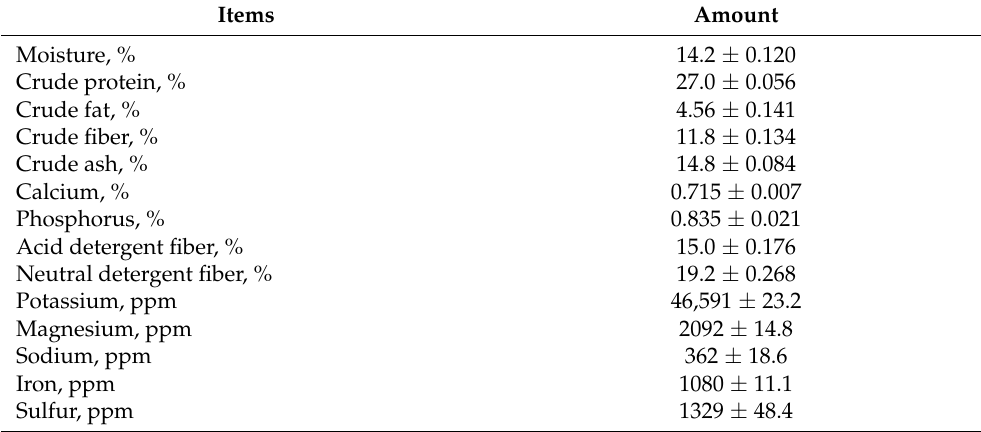
Table 1. The nutrient composition of pine needles 1